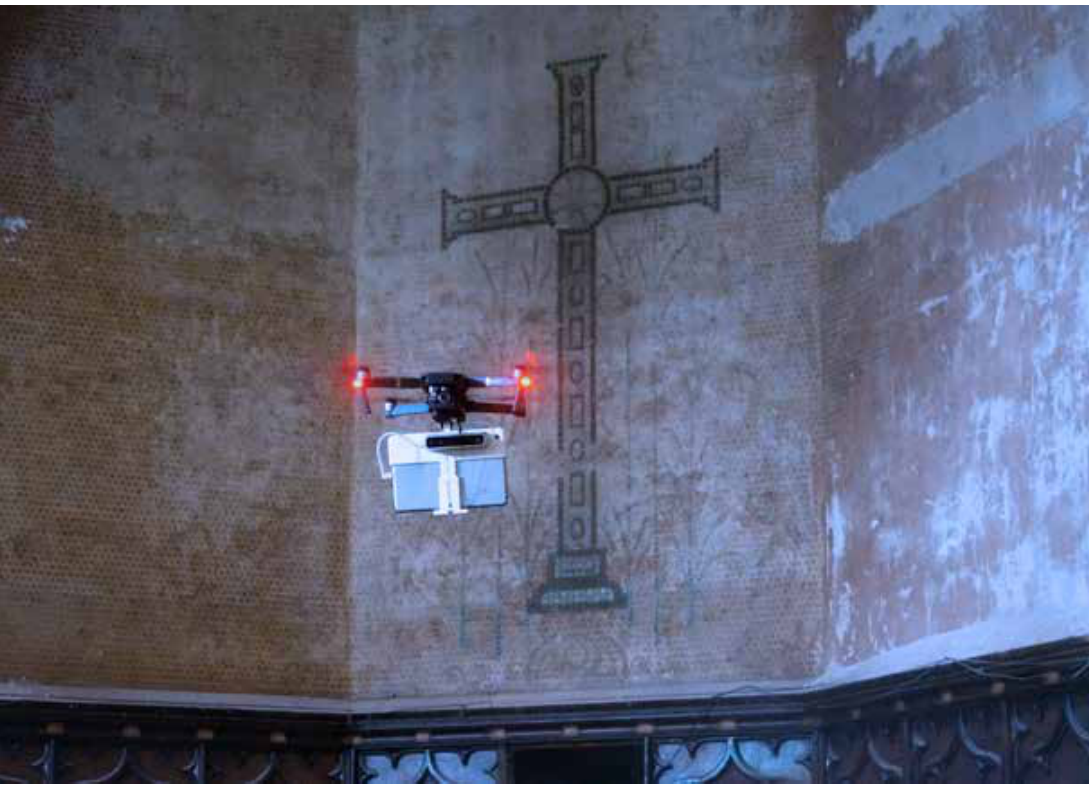
Figure 4 (top): Experimental survey conducted with a drone connected to a structure sensor for collecting data